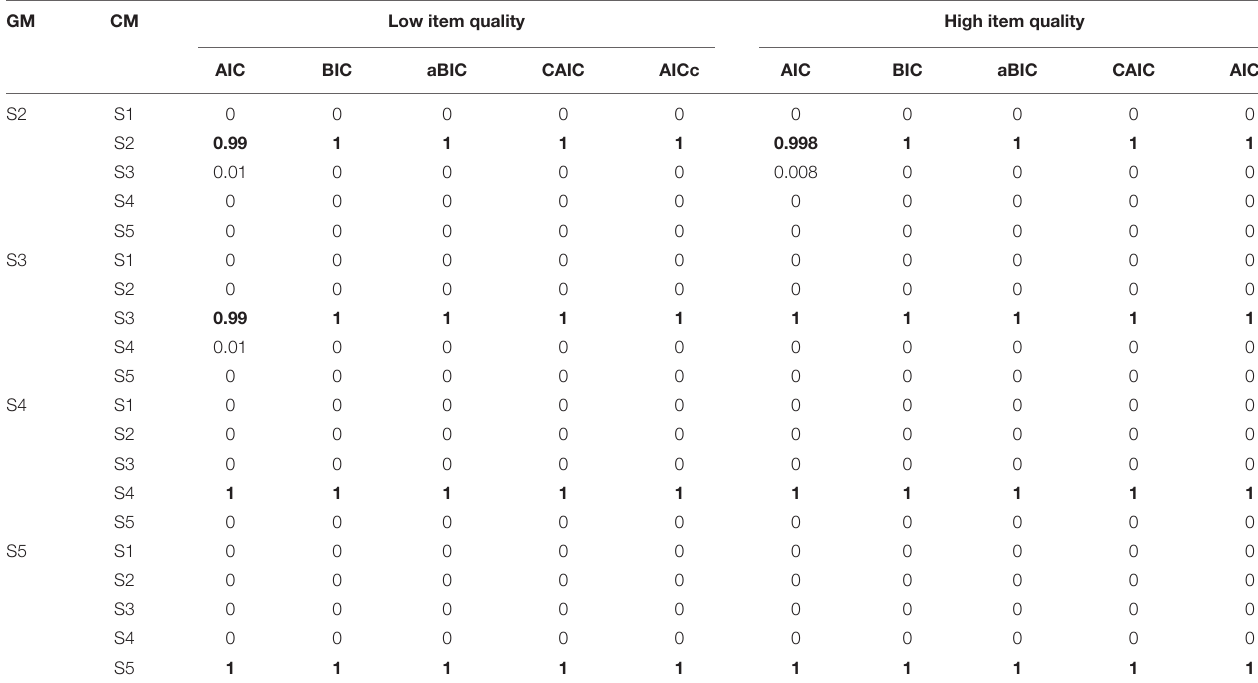
TABLE 6 | Correct detection rates of RFIs for different hierarchical attribute